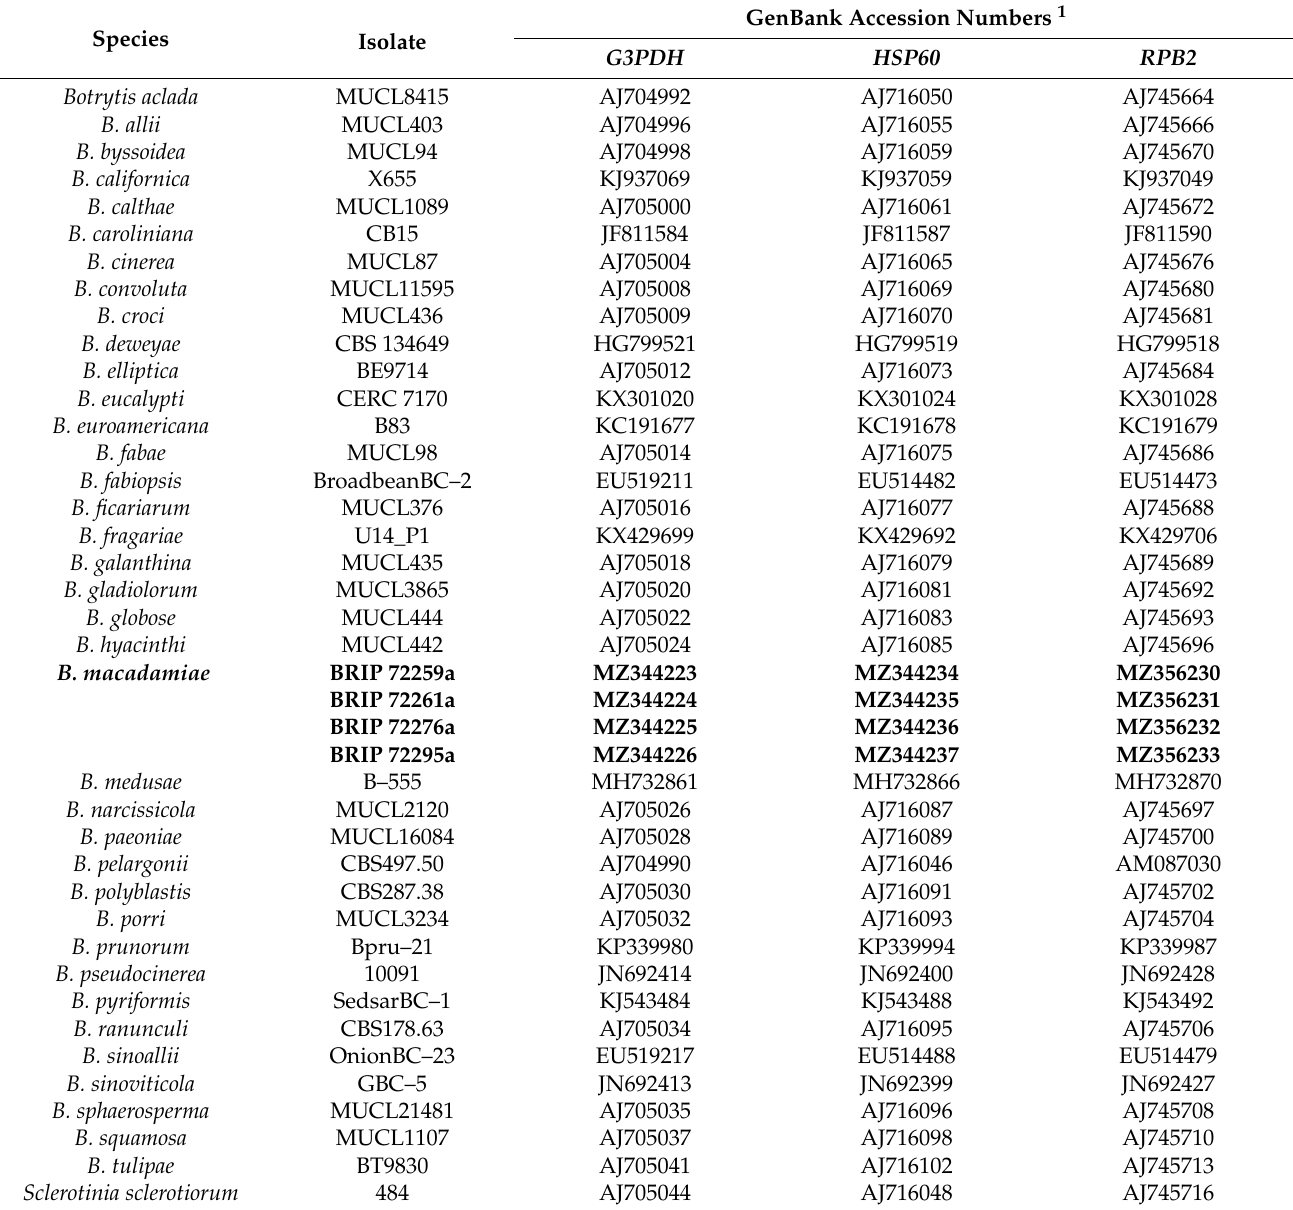
Table 2. Botrytis species and isolates used in the phylogenetic analysis with GenBank accession numbers. Species